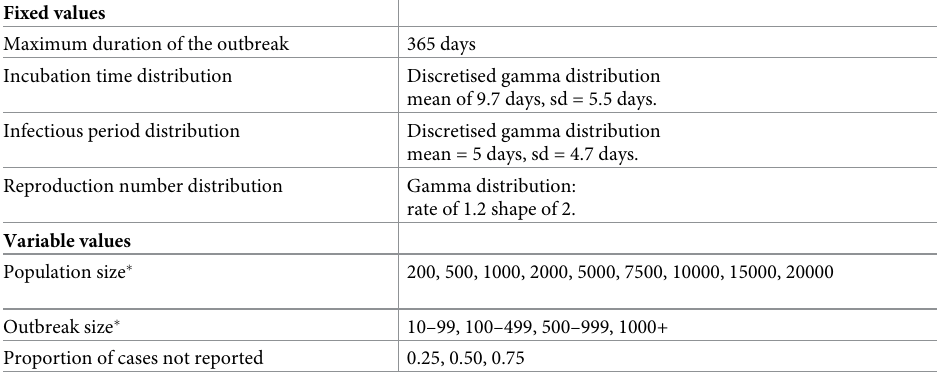
Table 1. Parameters used for simulating outbreaks. This table details input parameters used for simulating out- breaks using the R package simulacr . Fixed values were used for all simulations, and reflect the natural history of the 2018–2020 Eastern DRC Ebola outbreak. Variable values changed across